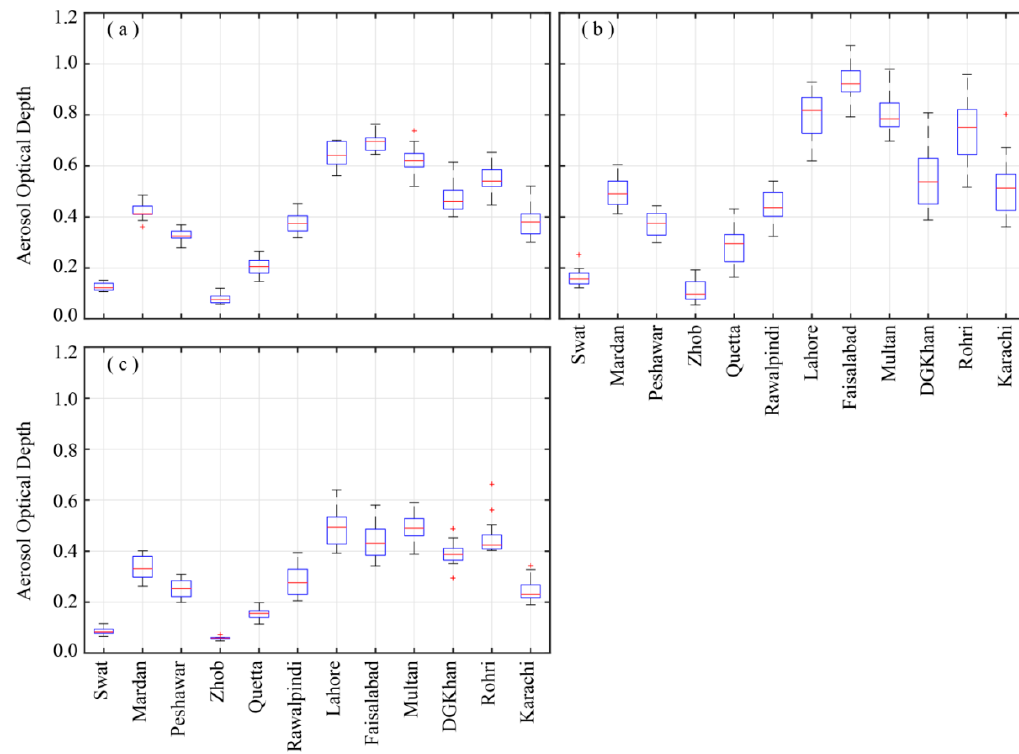
Figure 4. Variation of aerosol optical depth over selected regions during 2003–2017, ( a ) Annual, ( b ) Summer, ( c ) Winter, based on AOD data acquired from MODIS-Terra DB product. The central red line corresponds to the median and the box lower and upper edges represent the first and third quartiles respectively. The red signs, whether above or below of some of the whiskers represent the outliers which have a value more than 1.5 times the interquartile range .